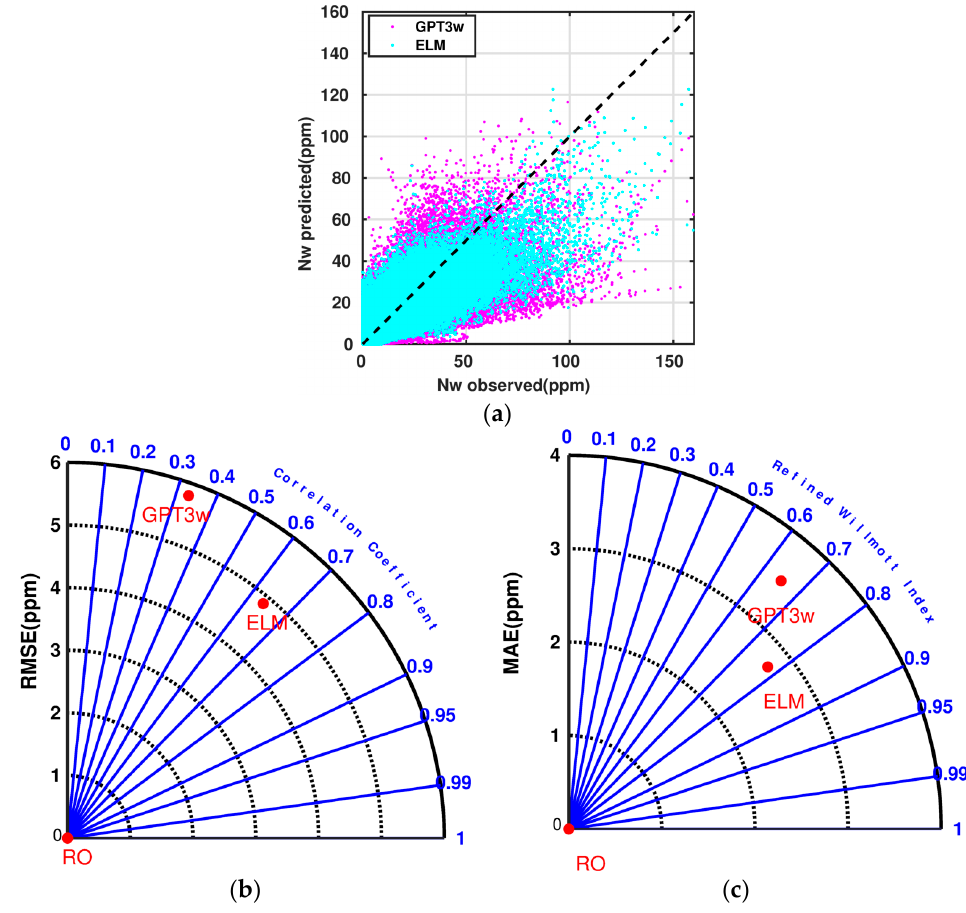
Figure 8. ( a ) Comparison of the ELM and GPT3w wet refractivity indices with the RO observations; ( b ) Calculated RMSE and correlation coefficients for ELM and GPT3w in the Taylor diagram; ( c ) Calculated MAE and Refined Willmott Index for ELM and GPT3w in the Taylor diagram.